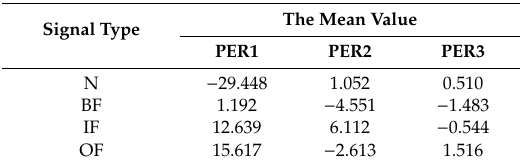
Table 2. Permutation entropy mean value of eigenvectors obtained by linear discriminant analysis (LDA).